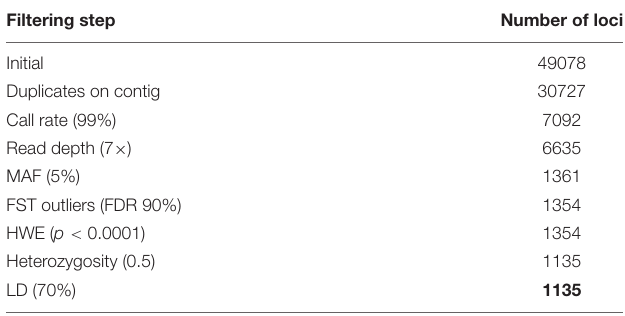
TABLE 1 | Number of loci remaining after each quality filtering step.